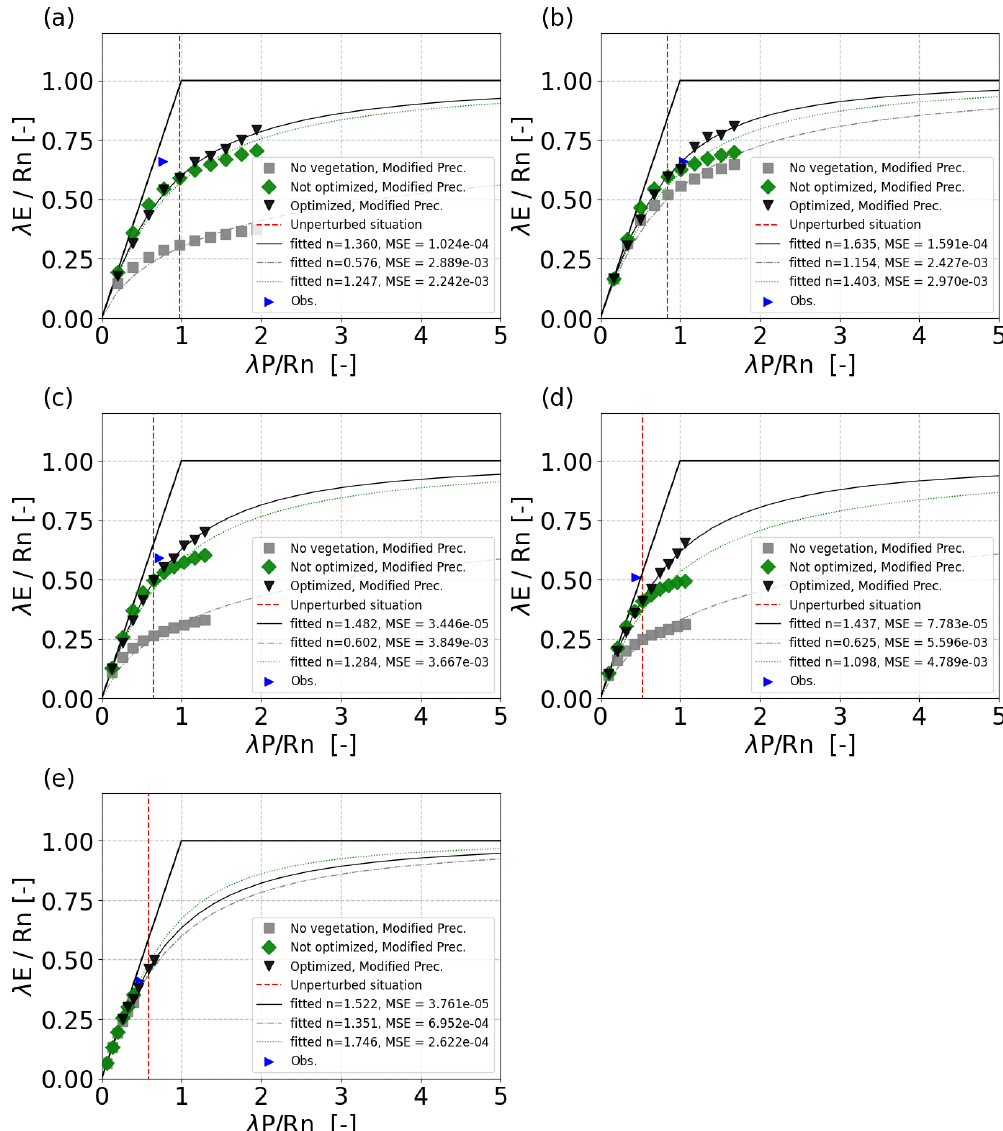
Figure 4. VOM results along the NATT in Budyko space as a result of modified precipitation for (a) Howard Springs, (b) Adelaide River, (c) Daly Uncleared, (d) Dry River, and (e) Sturt Plains. Gray squares denote simulations without vegetation (bare soil), black triangles denote fully optimized simulations, and green diamonds denote simulations where the VOM was run with the optimal vegetation properties determined for an unmodified climate. The unmodified climate is indicated by the dashed red line. The blue triangles denote the eddy covariance observations summed over the available period for each site. Lines are fits of Eq. (3) to the data points of the same